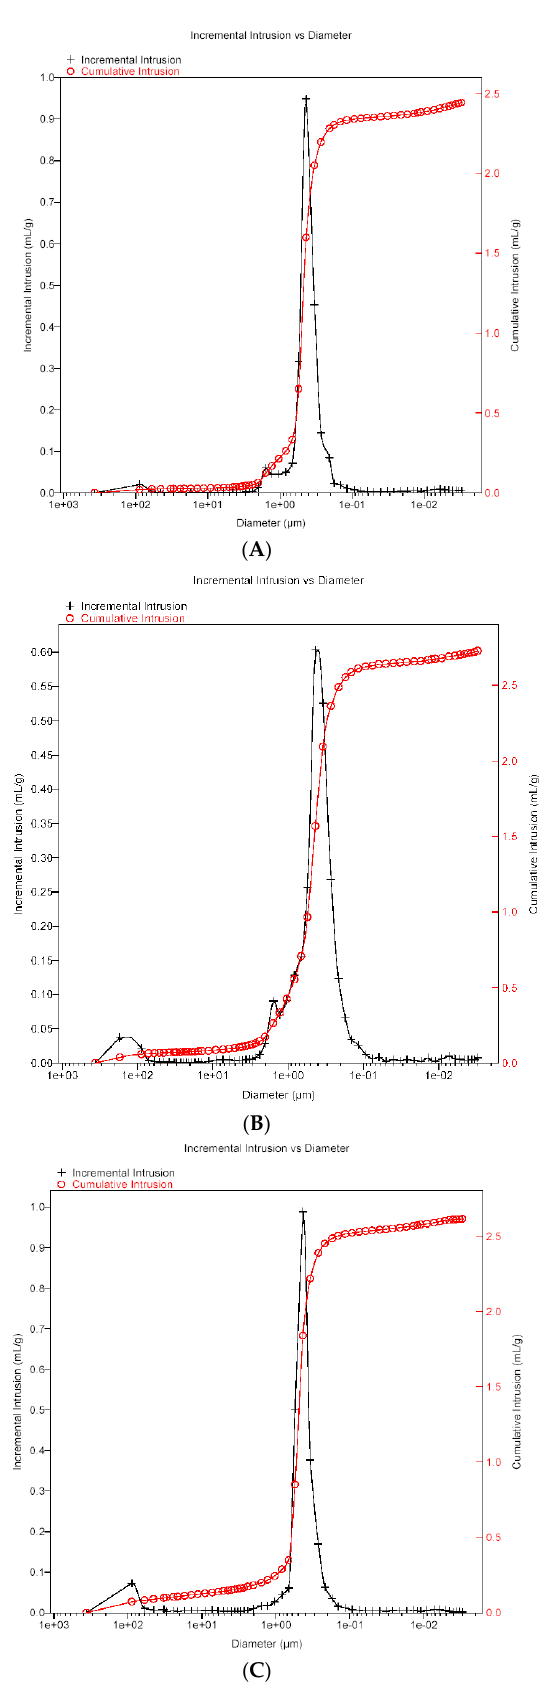
Figure 10. Distribution of pore sizes the studied capillary membranes. ( A ) Accurel PP S6/2, ( B ) K1800, and ( C ) EuroSep